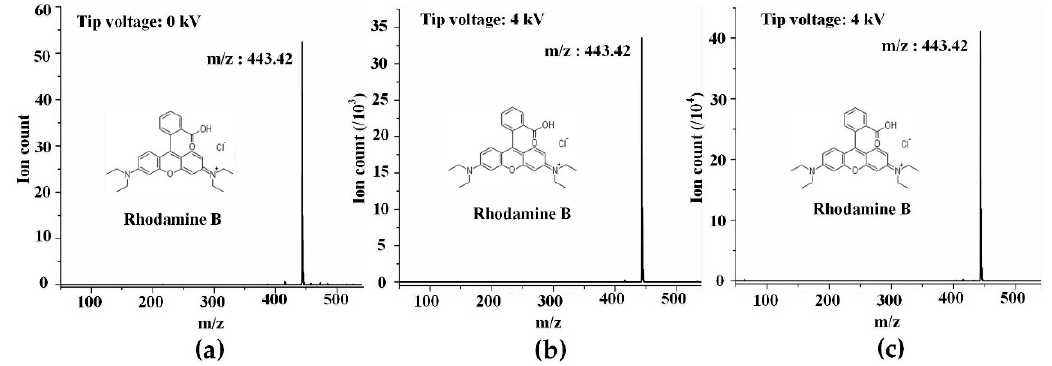
Figure 10. MS spectra of the 6 μ M solution of Rhodamine B molecules in methanol with 0.2% formic acid. The flow rate of the solution was 20 μ L/min, and the gas pressure for the ESFFI microfluidic chip was 300 mbar. ( a ) ESFFI microfluidic chip without high voltage. ( b ) ESFFI microfluidic chip with 4 kV. ( c ) Commercial ESI sources with 4 kV. In most cases, a high voltage was always applied on the